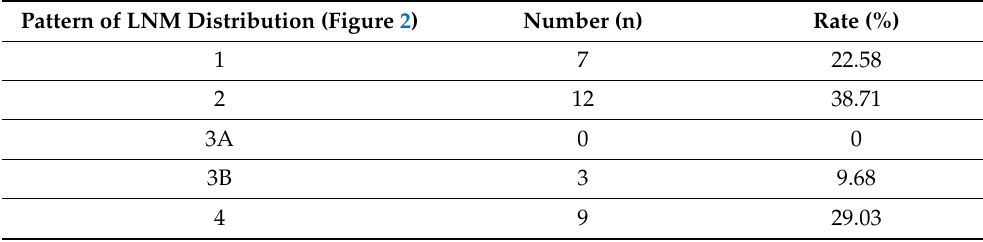
Table 5. Localization of LNM not detected on PET/CT in group 1.2. Pattern of LNM Distribution (Figure